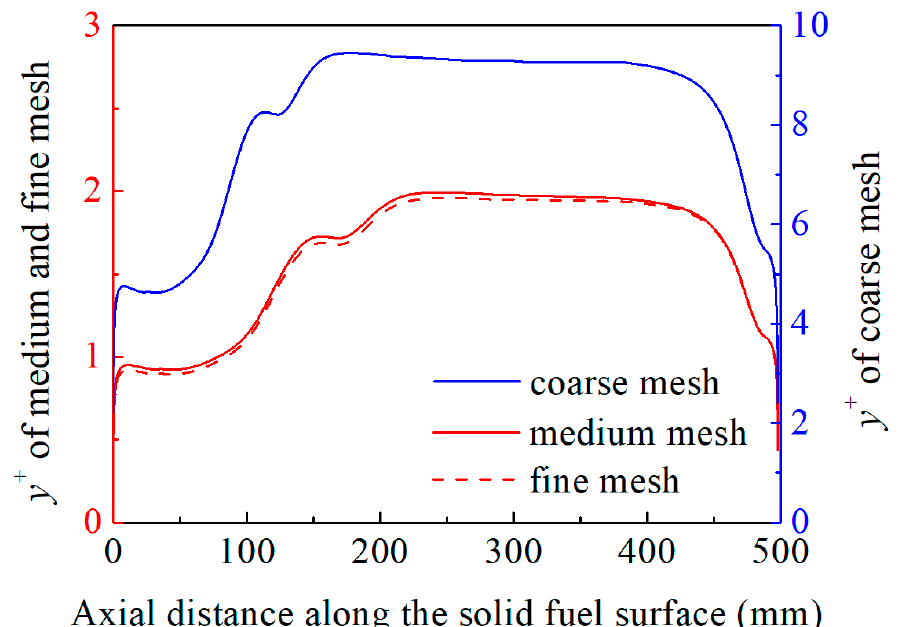
Figure 4. y + ( y -axis) along the fuel surface ( x -axis) of di ff erent mesh